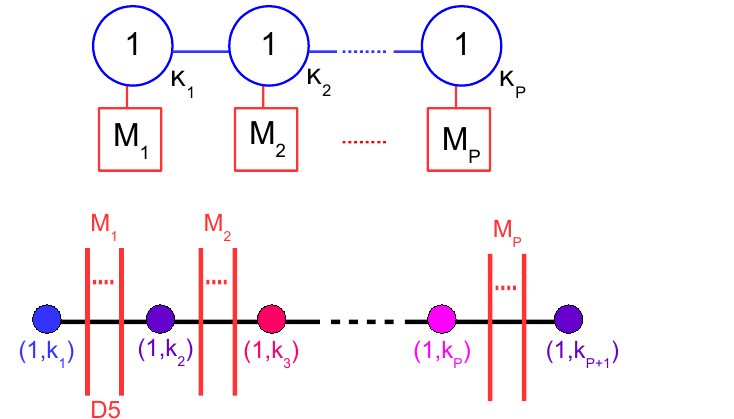
Figure 24 . Quiver and brane realization of an arbitrary abelian linear quiver N = 3 theory, with (cid:20) i = k i +1 (cid:0) k i